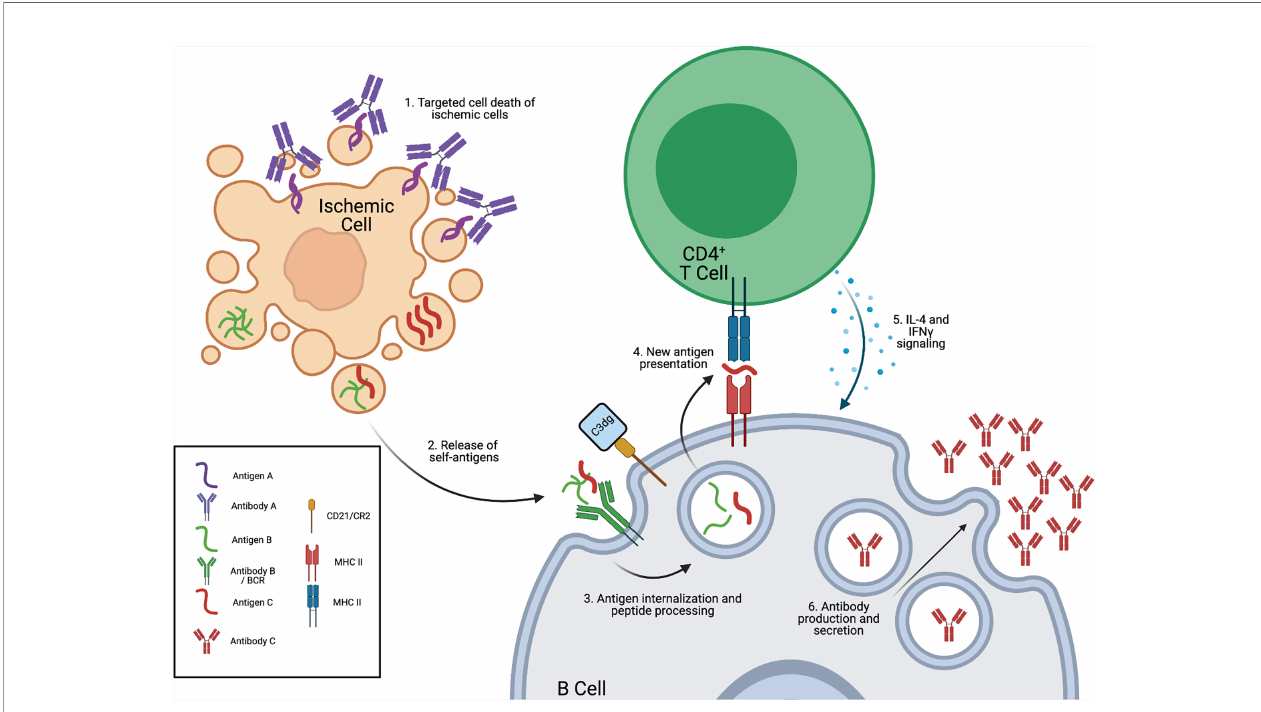
FIGURE 2 | Pre-existing autoantibodies could pre-dispose to heightened epitope spreading. The existence of lung targeted autoreactive antibodies generated pre- transplantation as a consequence of the recipient ’ s chronic lung diseases could exacerbate cellular injury. 1. Pre-existing lung autoreactive antibodies bind within the lung upon reperfusion and induce cell injury. 2. Injury to donor lung cells releases other self-antigens. 3. Self-antigens are internalized by antigen presenting cells and presented to T cells (4) and promote B cell production of autoreactive antibodies (5 and